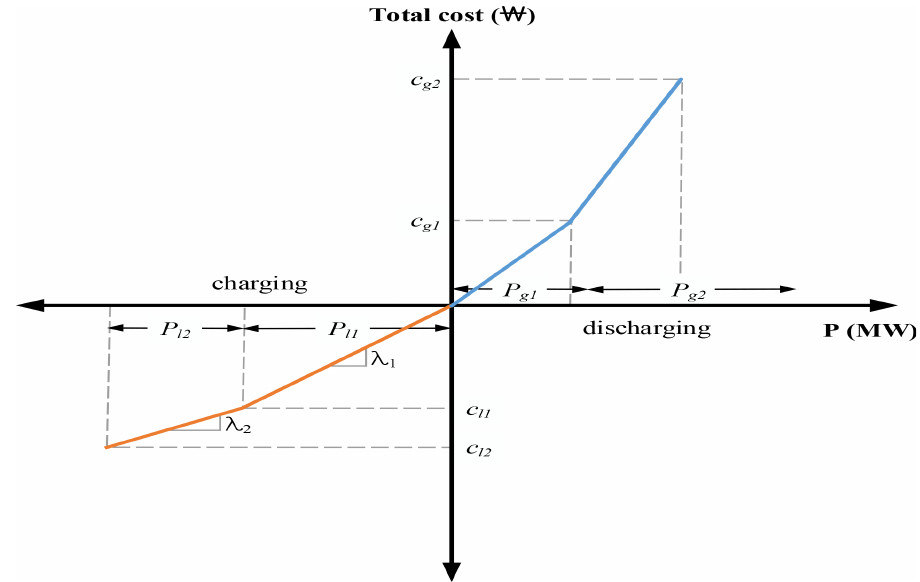
Figure 6. Cost curve for EV in charging and discharging